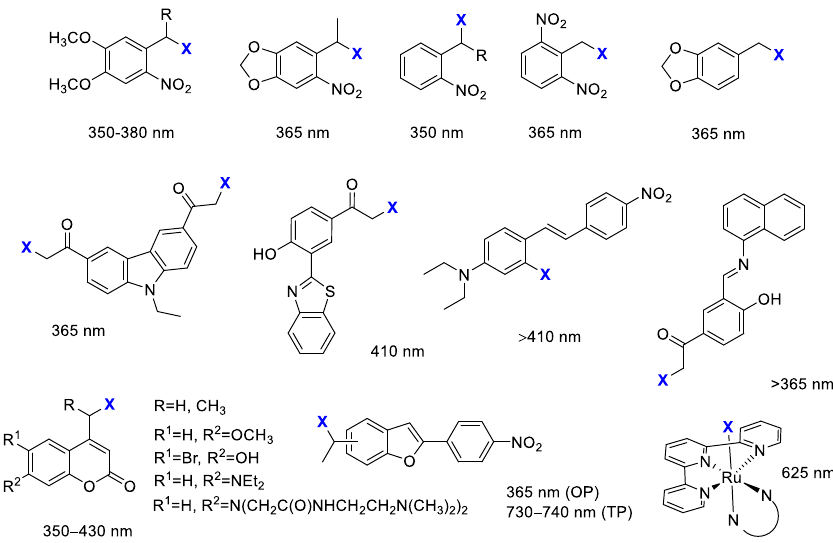
Figure 2. PPGs used in the discussed studies with their respective activation wavelengths.